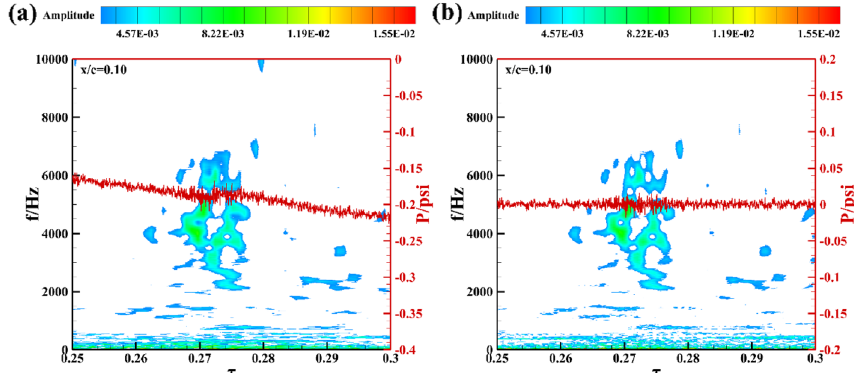
Fig. 11 Time-frequency analysis at x / c